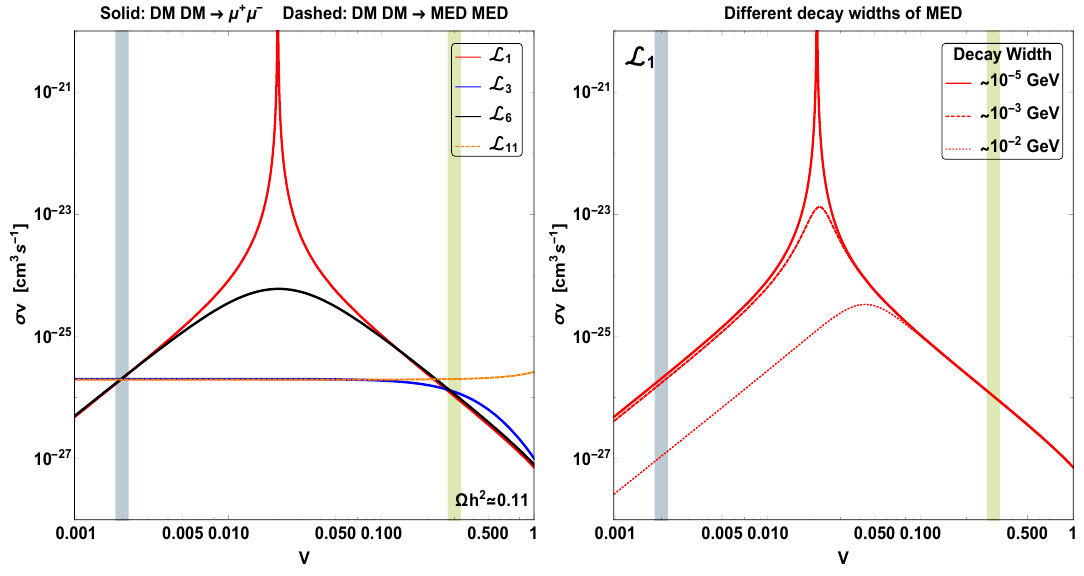
Figure 2 . The schematic demonstration of σv as function of v . The parameters of benchmark L 1 , 3 , 6 are m D / GeV = (72 . 99 , 73 . 11 , 73 . 02) , M/ GeV = (146 . 0 , 143 . 5 , 146 . 0) , and g D g f × 10 3 = (3 . 319 , 2 . 494 , 3 . 030) , respectively. For L (68 . 64 GeV , 5 . 85 GeV , 8 . 53 × 10 − 3 ) . The right panel is the result of L of